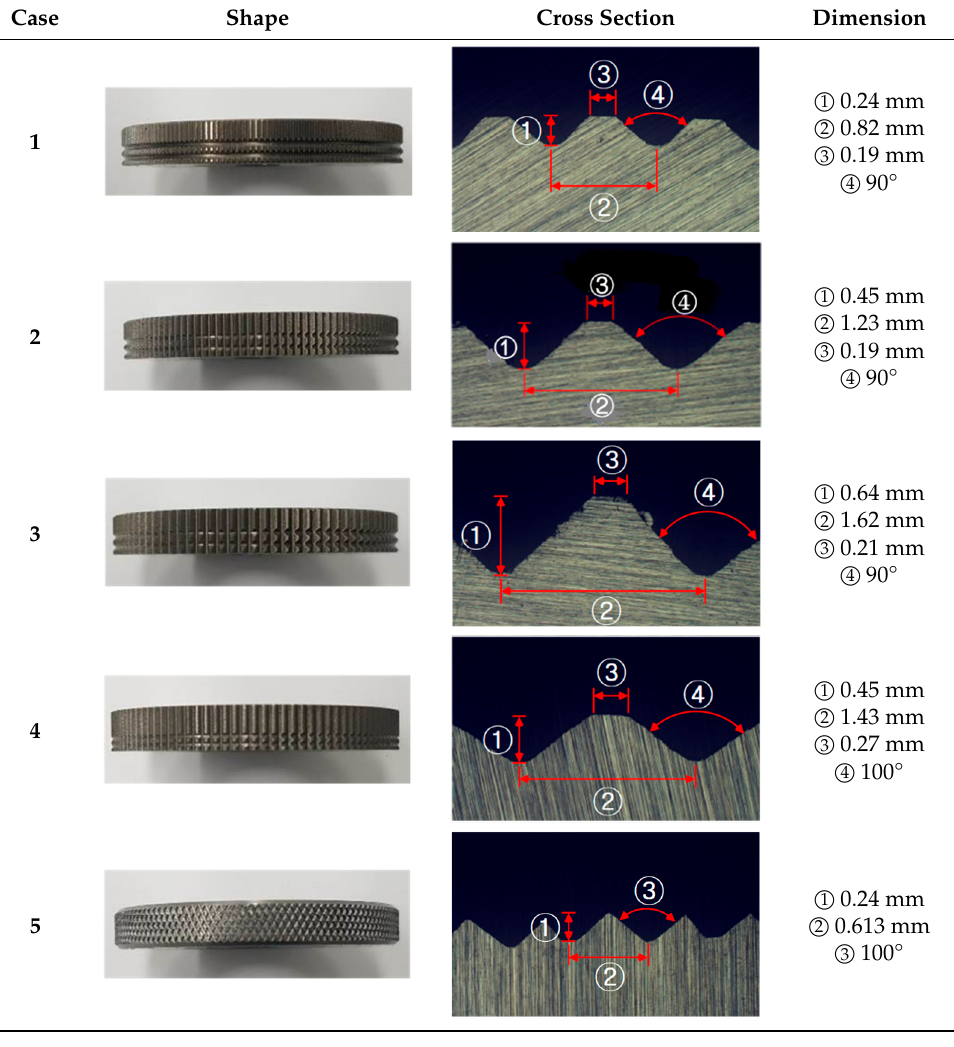
Table 4. Dimensions of fabricated serrations.